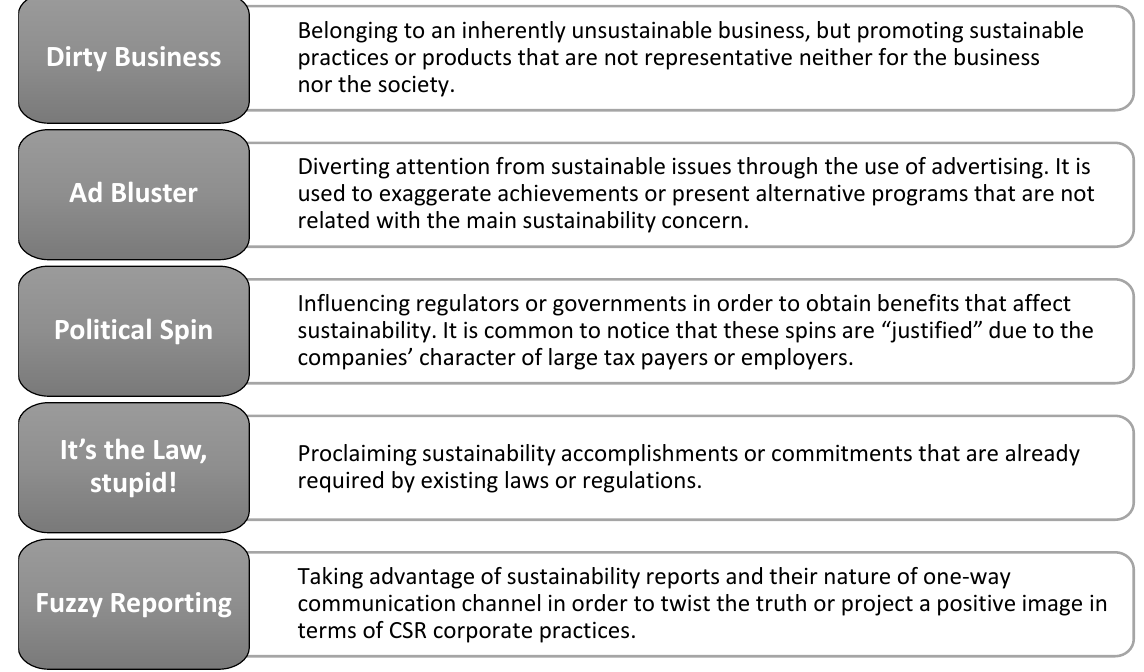
Figure 2. Greenwashing transgressions by